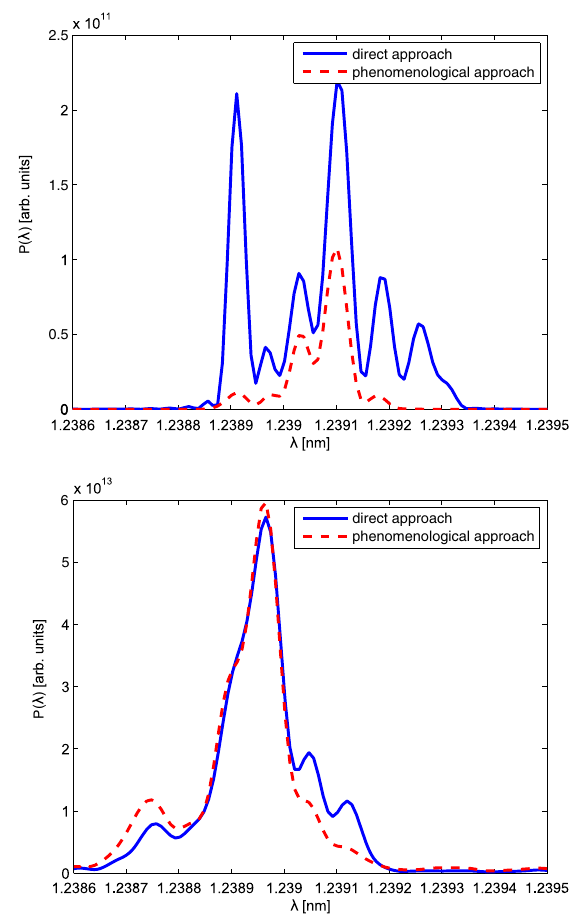
FIG. 16. Power of the radiation in seeded undulator. The radiation was propagated through the seeded undulator with the direct (solid line) and the phenomenological (dashed line) approaches. Photon energy is 1000 eV.